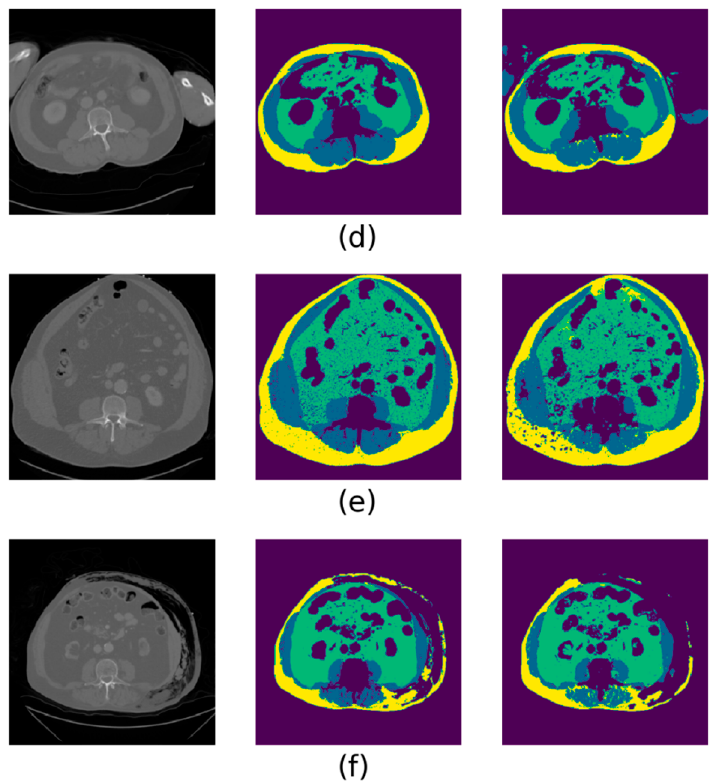
Figure 3. Selected examples of deep-learning automated segmentation results, with representative errors represented. In each image, the original L3 CT slice is shown on the left, the ground truth segmentation in the middle and the automated segmentation on the right. The color scheme is as follows—yellow: subcutaneous adipose tissue; blue: lumbar muscle; green: visceral adipose tissue. ( a ) An automatic segmentation that would be deemed clinically acceptable. ( b ) A CT “streak” scatter artefact near the spine that led to internal organs and adipose being mislabeled. ( c ) A case of an unknown foreign object lying under the left dorsolateral side of the patient, creating strong scatter artefacts that led to the misclassification of subcutaneous adipose as muscle. ( d ) A common event in the trauma dataset that was only rarely seen in the training dataset, i.e., hands and arms in the CT field of view being misclassified as lumbar muscle. ( e ) A noisier CT image than usual, resulting in spots of undetected adipose and muscle. ( f ) A rare case of post-traumatic subcutaneous emphysema, leading to missed detection of subcutaneous adipose.